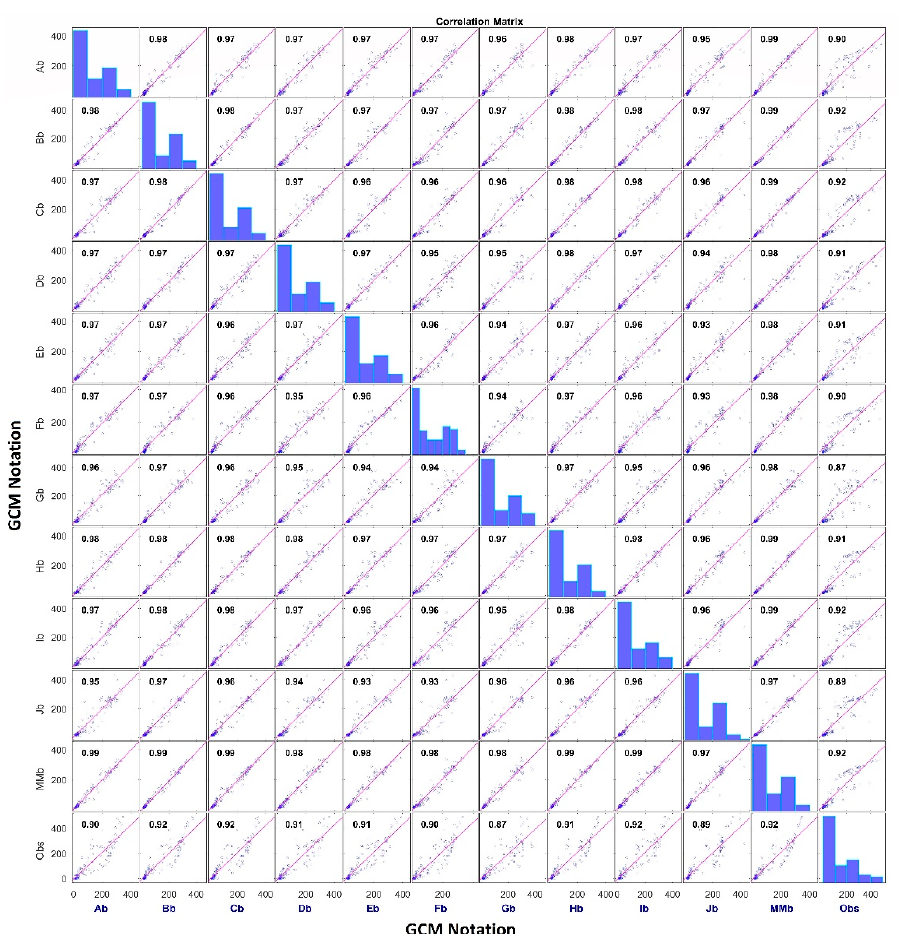
Figure 24. Correlation matrix of downscaled precipitation for different GCMs with the GCM-Obs model for Zone 4. Notations are similar to for Figure 23. for Zone 4. Notations are similar to for Figure 23. Water 2019 , 11 , x FOR PEER REVIEW